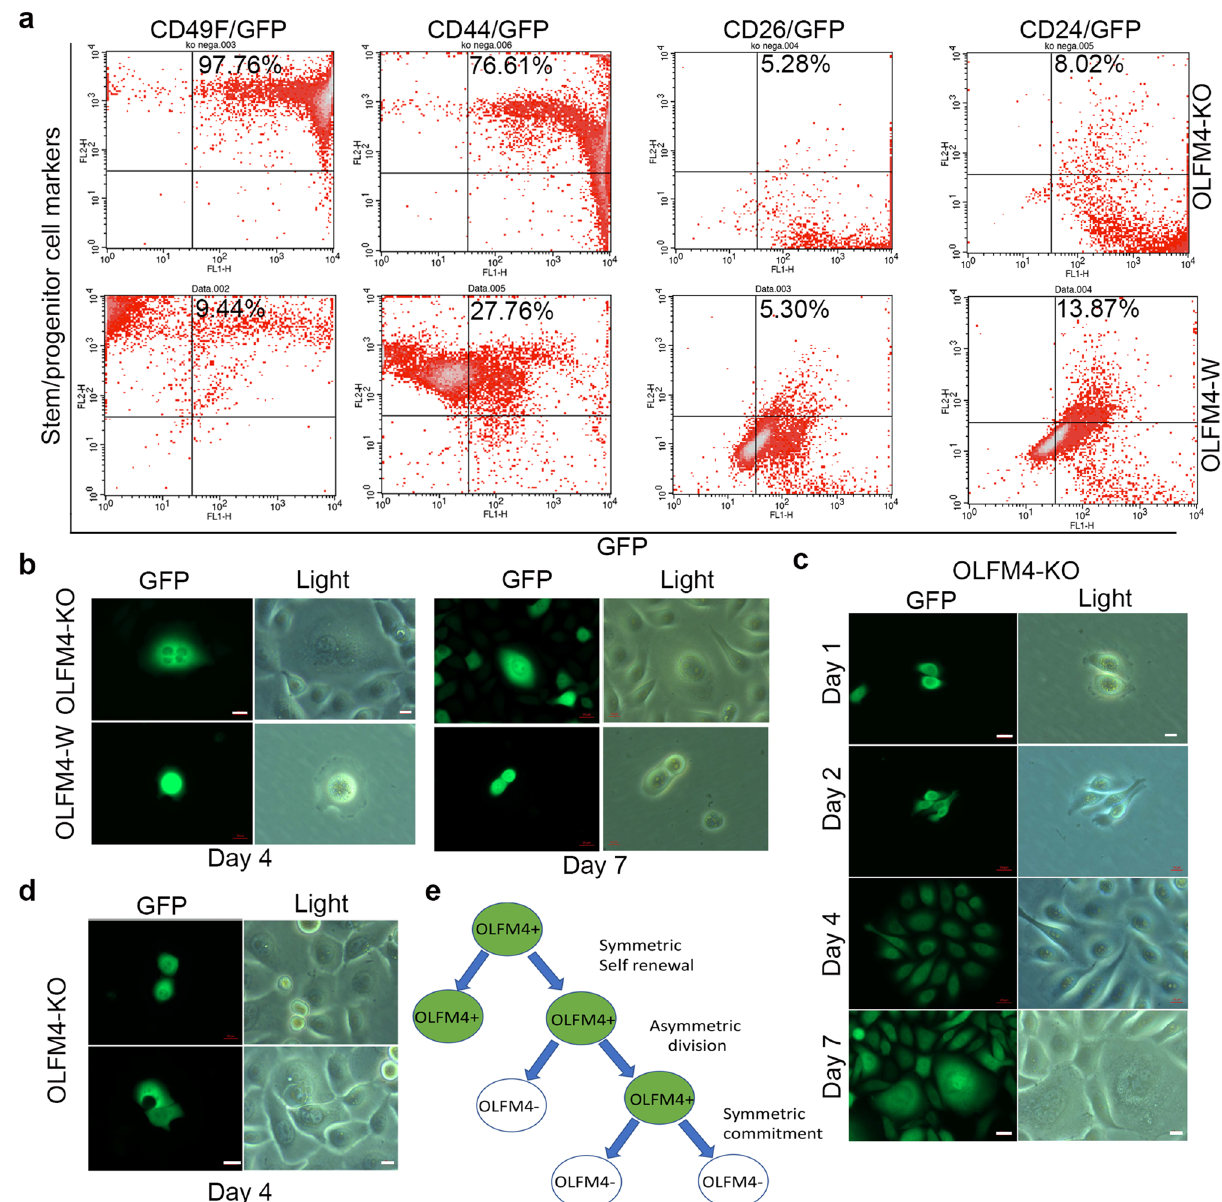
Figure 3. Characterization of OLFM4 -knockout GFP reporter RWPE1 cells in 2D culture. ( a ) Representative FACS analysis of OLFM4 -wild and OLFM4 -knockout GFP reporter RWPE1 cells using antibodies to GFP combined with antibodies to stem/progenitor-cell markers CD49F, CD44, CD26, or CD24. Inset values indicate the percentage of double-marker—positive cell populations. ( b ) Representative GFP- and light-field images generated using single-cell tracing of OLFM4 -wild and OLFM4 -knockout GFP reporter RWPE1 cells at 4 and 7 days in 2D culture. Scale bar: 10 µm. ( c ) Representative GFP- and light-field images of OLFM4 -knockout GFP reporter RWPE1 cells at 1, 2, 4, and 7 days in 2D culture. Scale bar: 10 µm. ( d ) Representative GFP- and light-field images of OLFM4 -knockout GFP reporter RWPE1 cells at 4 days in 2D culture. Scale bar: 10 µm. ( e ) Illustration of OLFM4 -expressing GFP-positive RWPE1 stem/progenitor-like cell symmetric and asymmetric division. OLFM4-KO, knockout; OLFM4-W,